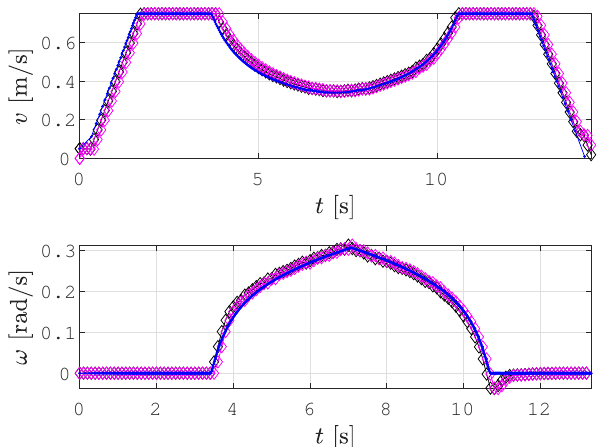
Figure 7. The calculated linear and angular velocities (blue line) and real linear and angular velocities (magenta diamonds) at which the robot tracked the